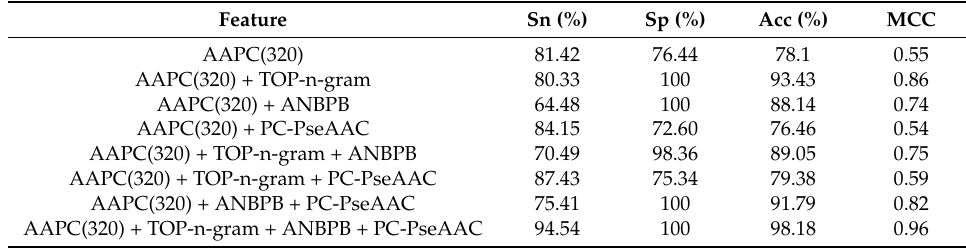
Table 2. Predictive performance of TOP-n-gram, adapted normal distribution bi-profile Bayes (ANBPB), and parallel correlation pseudo amino acid composition (PC-PseAAC) using the jackknife test.